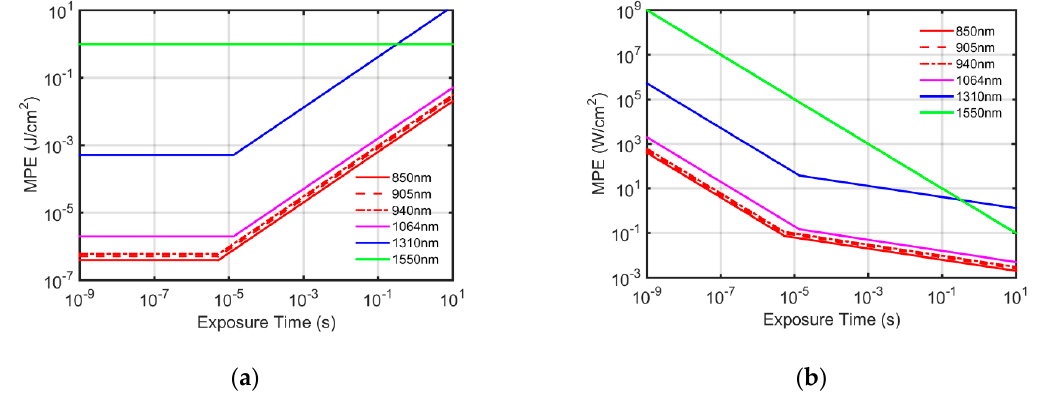
Figure 1. Calculated maximum permissible exposure (MPE) according to IEC 60825-1 (2014), ( a ) in J / cm 2 and ( b ) in W / cm 2 , of point laser sources at wavelengths of 850 nm, 905 nm, 940 nm, 1064 nm, 1310 nm, and 1550 nm respectively as a function of exposure time.